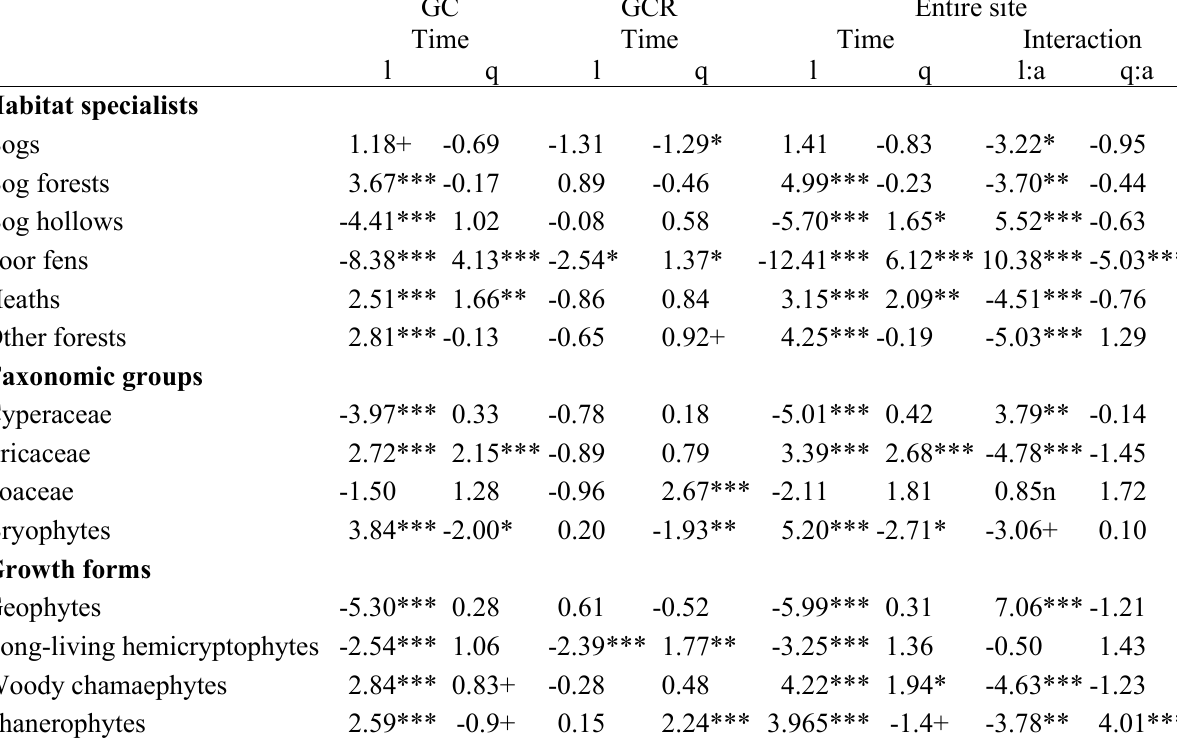
Table 3. Trends of the cumulative relative cover of species belonging to various habitats, taxonomic groups and growth forms (only vascular plants) in the two areas (GC and GCR) and the entire site. Results of separate regression models for the GC-area and GCR-area, as well as results from the combined model, are shown. Numbers are the effect sizes of the orthogonal polynomials of time and their interaction with area type. GC = grazing cessation; GCR = grazing cessation and rewetting; l:a = interaction linear term between time and area type; q:a = interaction quadratic term between time and area type. Significance levels: +: p ≤